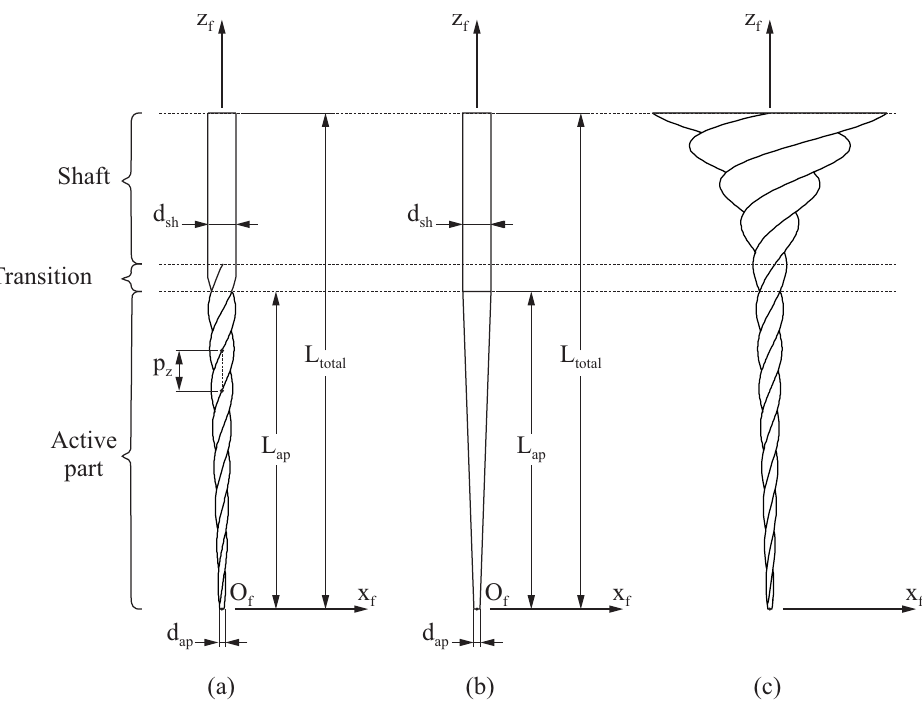
Figure 1. Definition of the geometry of the endodontic file ( a ), the raw material ( b ) and the machined material ( c ).